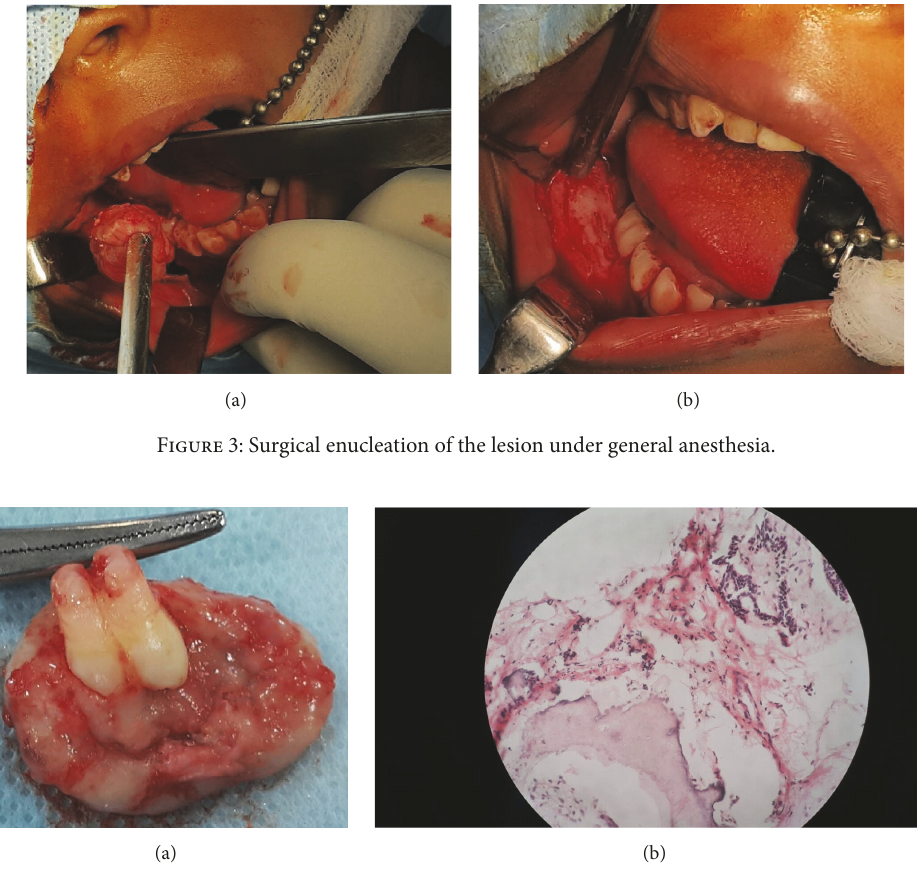
Figure 4: Histopathological specimen (a) reveals the presence of the lesional tissue in toto along with the attached tooth specimen. (b) Histopathology shows odontogenic epithelium with peripheral palisading nuclei resembling ameloblast-like cells and loosely arranged central cells, identical to stellate reticulum, embedded in a myxoid cell-rich stroma resembling the dental papilla. Focal areas of enamel and dentin are also